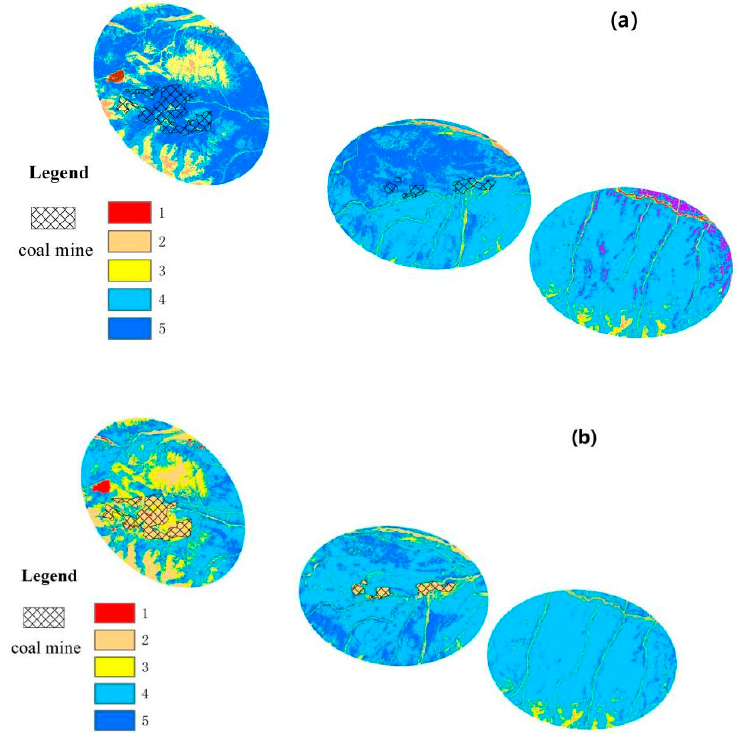
Figure 3. Vegetation coverage levels around coal mines in 2002 ( a ) and 2016 ( b ). In ( a ) and ( b ), the left and middle maps are the vegetation distribution maps of the mining-affected area, while the rightmost map is the contrast test area.